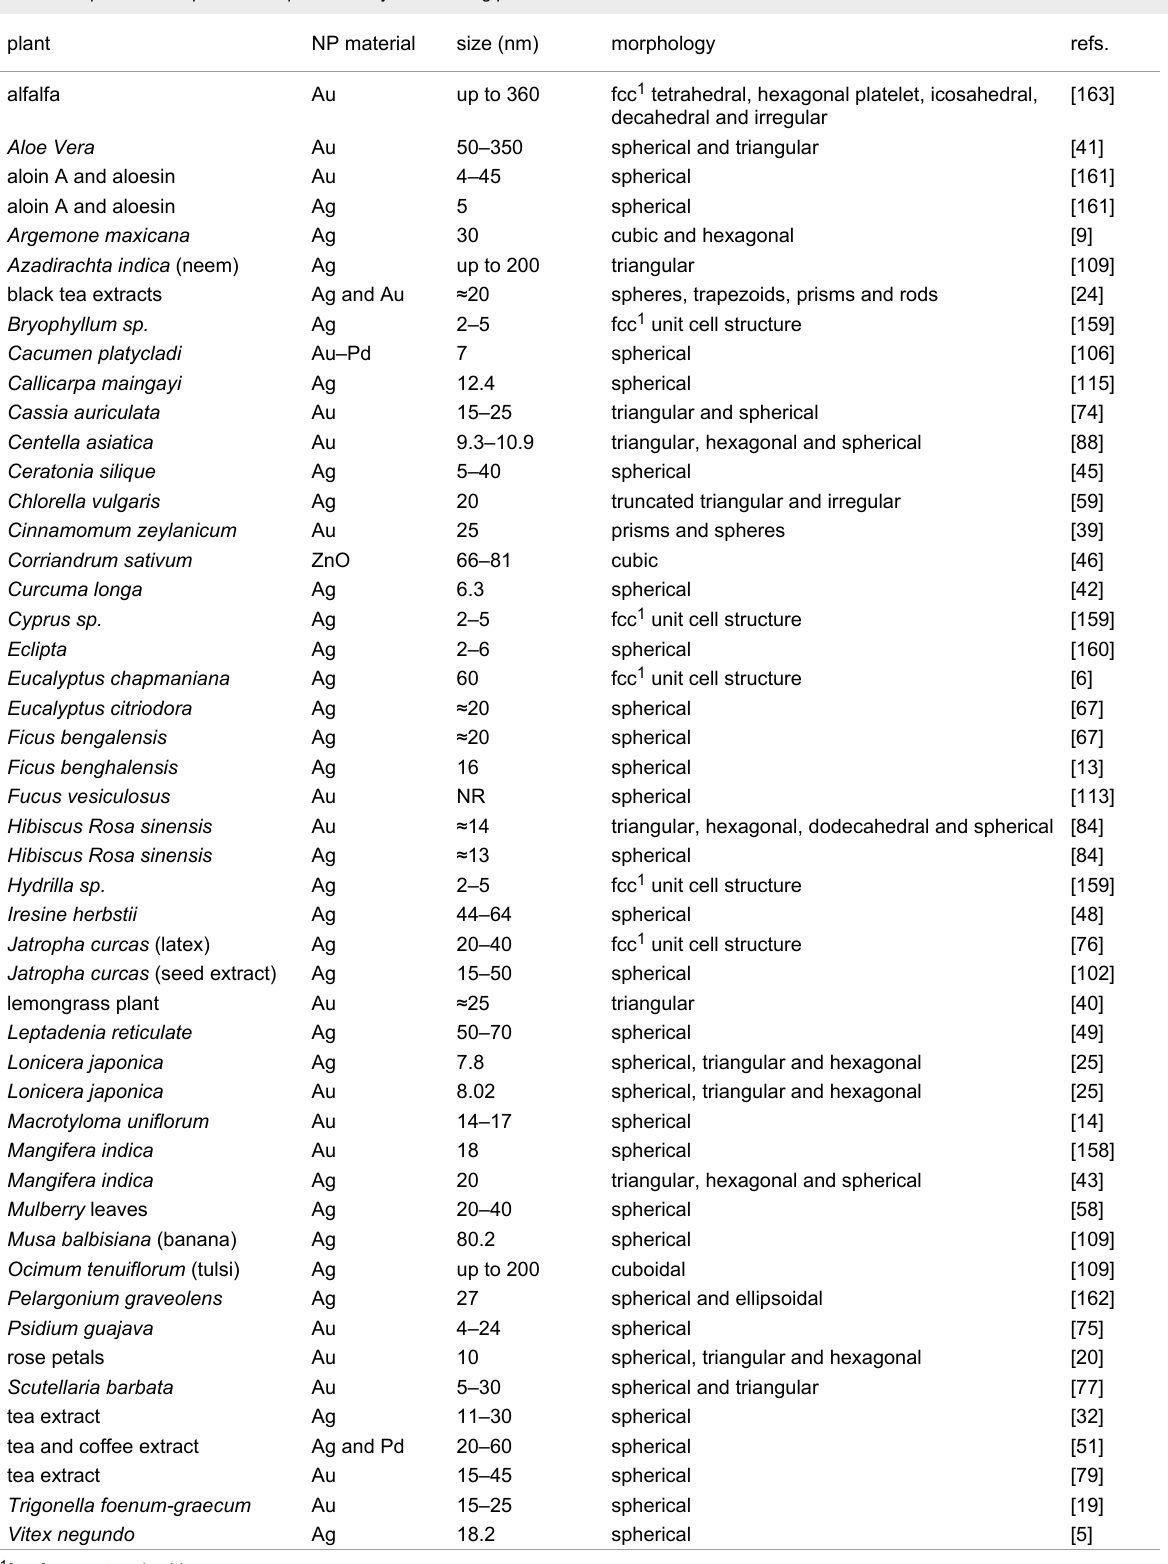
Table 3: Important examples of nanoparticle biosynthesis using plants.